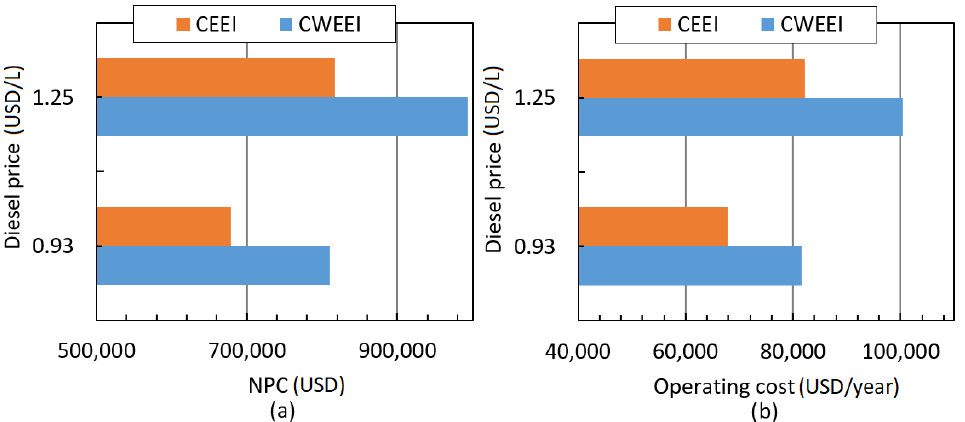
Figure 7. Costs of the CEEI and the CWEEI for SPVS/diesel generator configuration, ( a ) NPCs, and ( b ) Operating costs.